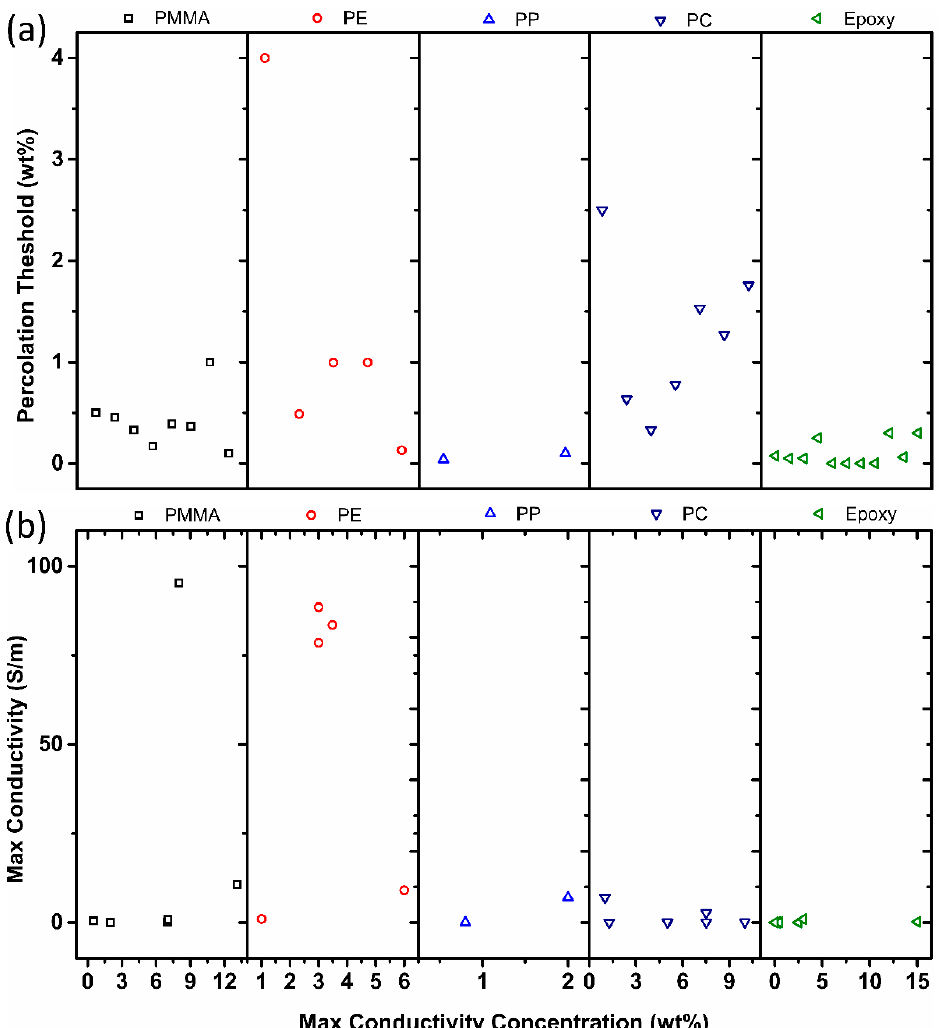
Figure 27. ( a ) Percolation threshold and ( b ) max conductivity values at various SWCNT contents for several SWCNT/polymer systems [25,51,56,73–93]. See Table S2 for specific details.